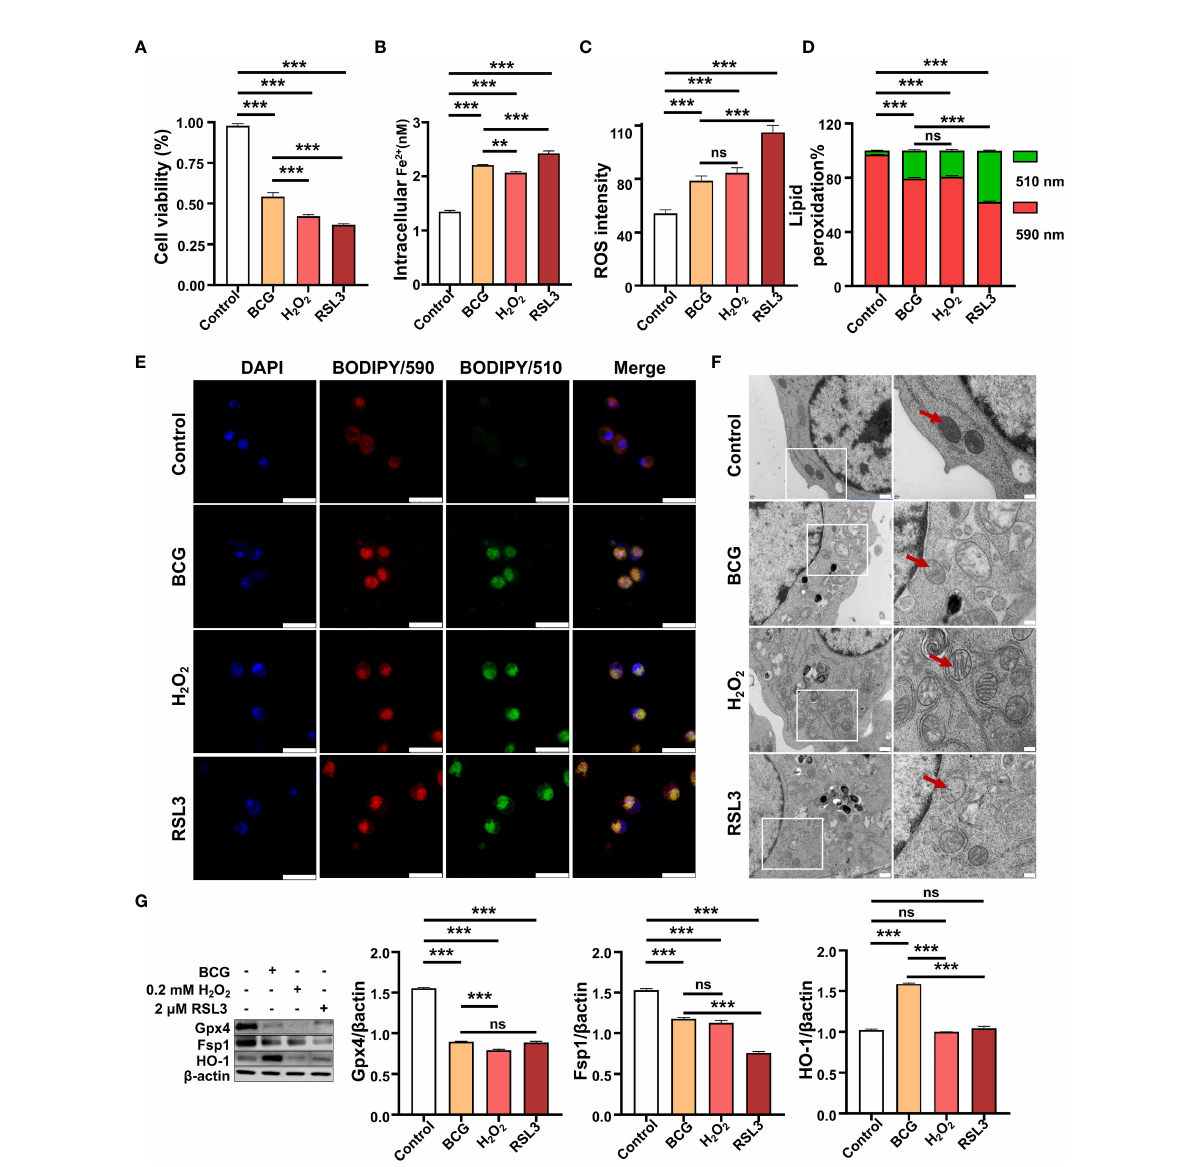
FIGURE 4 BCG induces intracellular ROS production and ferroptosis in RAW264.7 macrophages. (A – D) The viability (A) , intracellular Fe 2+ (B) , intracellular ROS (C) , and lipid peroxidation (D) of RAW264.7 macrophages in response to BCG infection (MOI 5), ferroptosis agonist RSL3 (2.0 µM), and H 2 O 2 (0.2 mM), major participants of the Fenton response at 24 h post-treatments, as determined by Trypan Blue assay, iron ion probes, fl ow cytometry, and BODIPY 581/591 C11 assays, respectively. (E) Representative fl uorescence images of BODIPY 581/591 C11-labeled lipoxidation of polyunsaturated fatty acids in RAW264.7 macrophages infected with BCG (the second panel from top), treated with H 2 O 2 (the second panel from bottom), and RSL3 (bottom panel). Cell nuclei were counterstained with DAPI. (F) Representative images of transmission electron microscopy showed mitochondrial membrane ridge breaks (arrows) in RAW264.7 macrophages infected with BCG (the second panel from top), treated with H 2 O 2 (the second panel from bottom) and RSL3 (bottom panel). The right panel shows the enlarged image of the boxed area in its corresponding image in the left panel. (G) Representative blots and semi-quantitative analysis of Gpx4, Fsp1, and HO-1 proteins of RAW264.7 cells treated with the indicated conditions. The infection of BCG increased intracellular Fe 2+ level and induced ROS (H 2 O 2 ) production and lipid peroxidation and ferroptosis in macrophages, by inhibiting Gpx4 and Fsp1 but inducing HO-1 expression. Data obtained from three independent experiments were processed using GraphPad Prism 8.0.1 software and ImageJ 1.52.a. One-way ANOVA was used to analyze the differences between groups. All values are presented as mean ± SD (** p < 0.01, and *** p < 0.001; n = 3). Bars, 500 nm in the right panel and 200 nm in the left panel of E, 25 m m in F. ns, no statistical